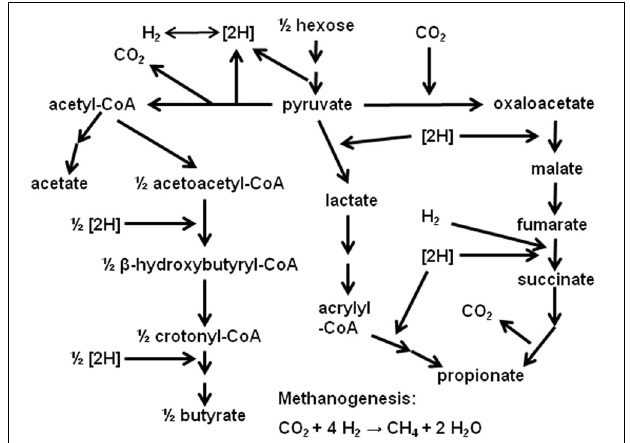
FIGURE 1 | Main ruminal fermentation pathways.